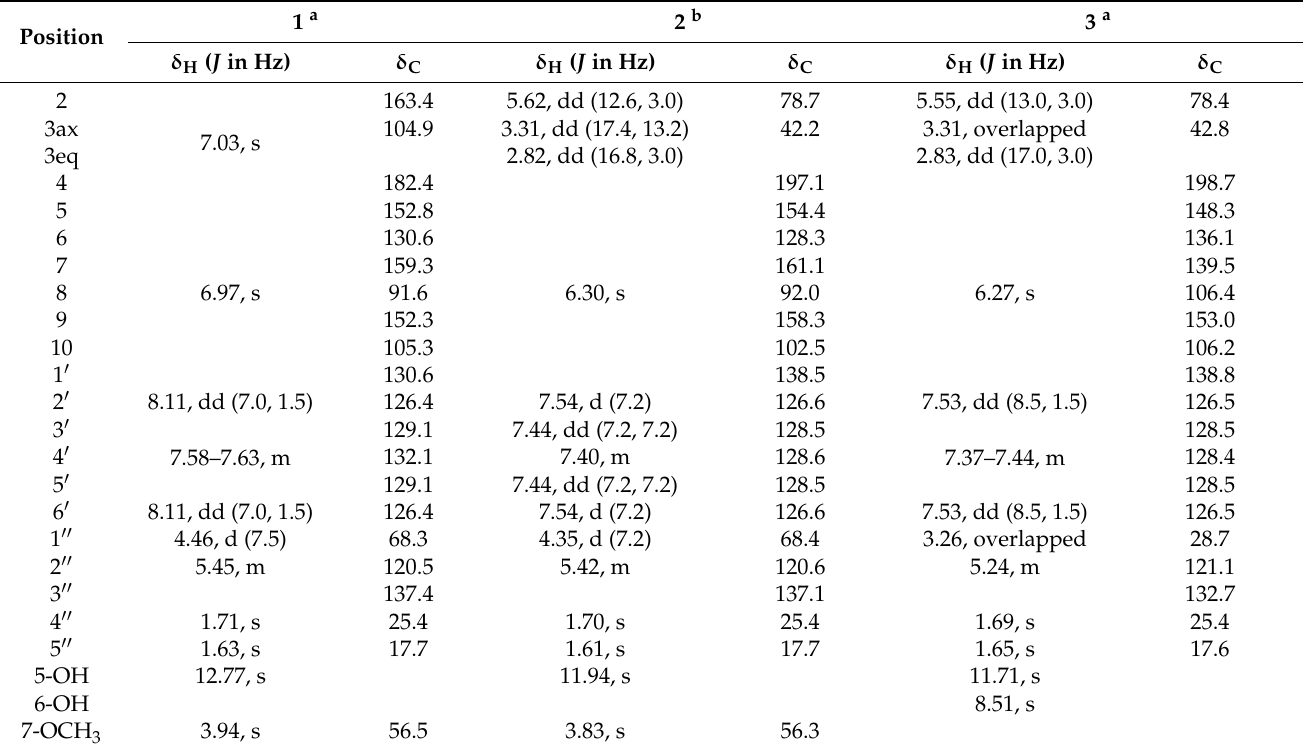
Table 1. 1 H and 13 C NMR spectroscopic data of 1 – 3 recorded in DMSO- d 6 ( δ in